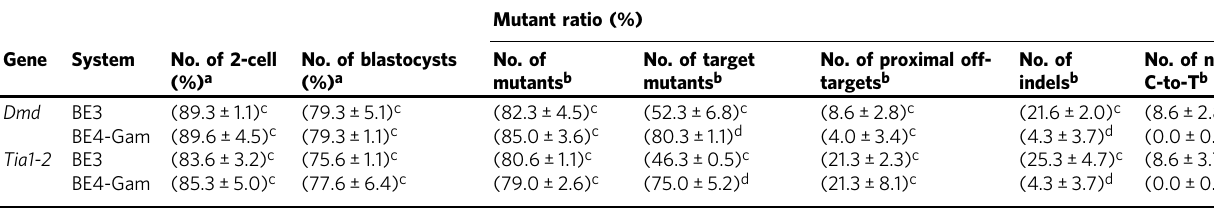
Table 3 BE4-Gam system improves product purity in rabbit blastocysts